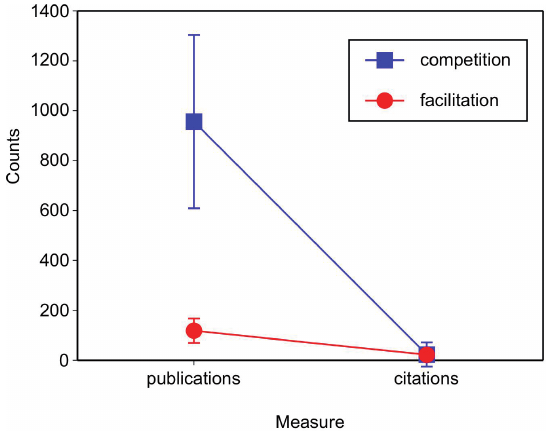
Figure 1. The total number of publications and citations per pub- lication for studies on plant competition and facilitation. These data were generated using the Web of Science in May 2009 with appropriate search terms for the major themes generally explored in ecology as a discipline. The mean ±1 SE is